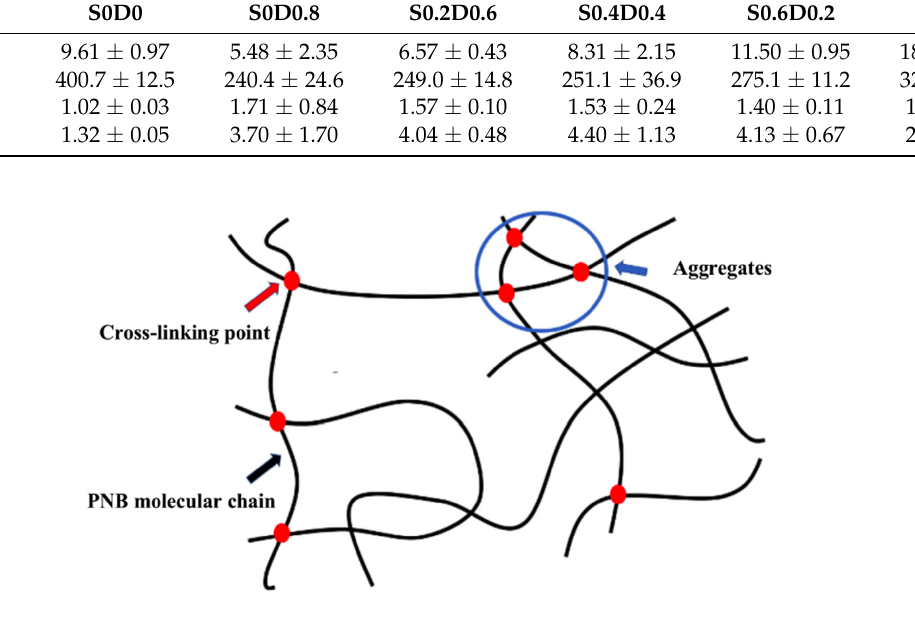
Figure 4. Schematic diagram of the structural characteristics with DCP crosslinking network. Table 3. Mechanical properties of PNB at 24 °C.